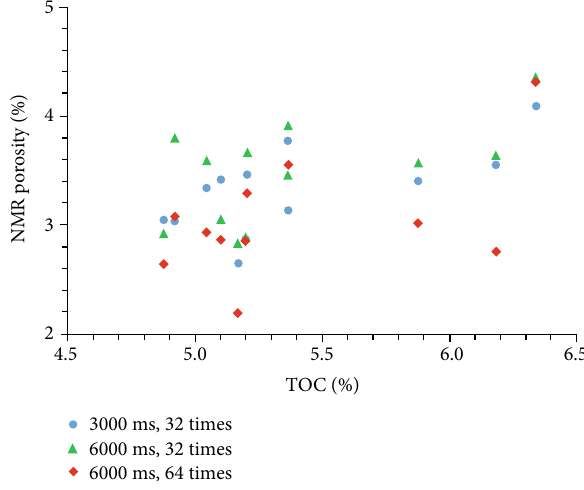
Figure 4: Histogram comparison of porosities from the four di ff erent methods for each sample.